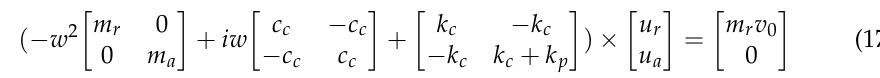
By converting Equations (14) and (15) to the frequency domain and considering a pseudo-force whose value is equal to the modulus of the momentum transferred from the ram to the pile, the displacement values of the ram and the anvil can be computed by solving the following system of equations: